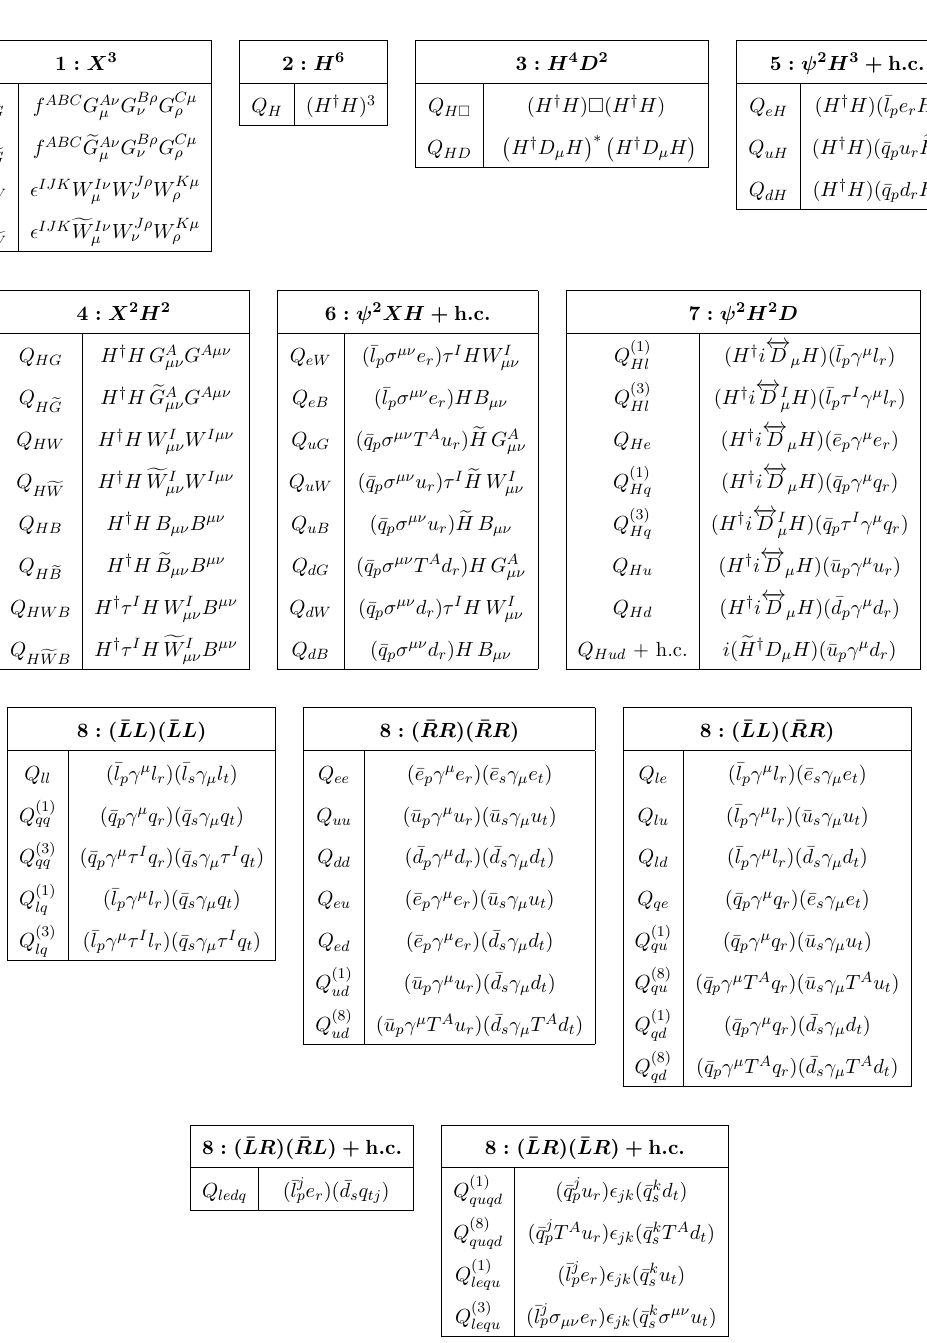
Table 5 . The 76 dimension-six operators that conserve baryon and lepton number in SMEFT. The operators are divided into eight classes according to their field content. The class-8 ψ 4 four-fermion operators are further divided into subclasses according to their chiral properties. Operators with + h . c . have Hermitian conjugates, as does the ψ 2 H 2 D operator Q Hud . The subscripts p, r, s, t are weak-eigenstate